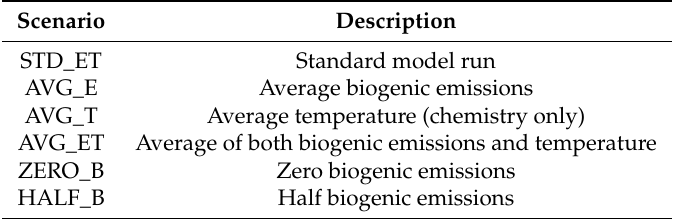
Table 2. Summary of sensitivity studies used in this